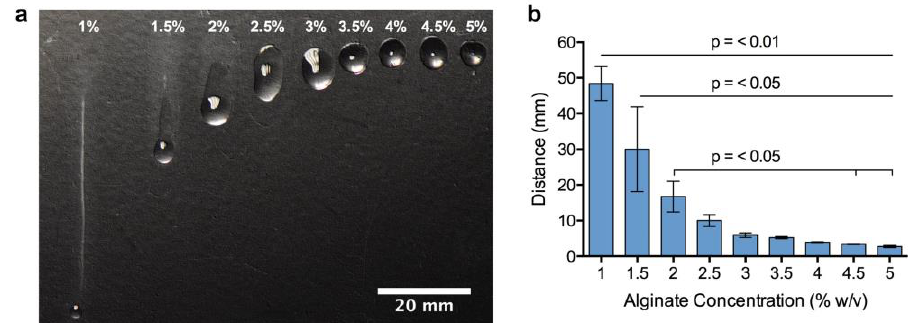
Figure 2. Comparative viscosity of different bioink formulations. ( a ) Calcium alginate beads were dissolved in 50 mM sodium citrate before mixing with HV-alginate to reach final concentrations of between 1 and 5%. 300 µL drops were placed on a glass slide for 15 min and relative viscosity was assessed by the distance the drop fell ( b ). Bioinks able to hold their shape were considered suitable for printing. Values are presented as means ± SD from 3 independent experiments. p < 0.05 was considered significant.